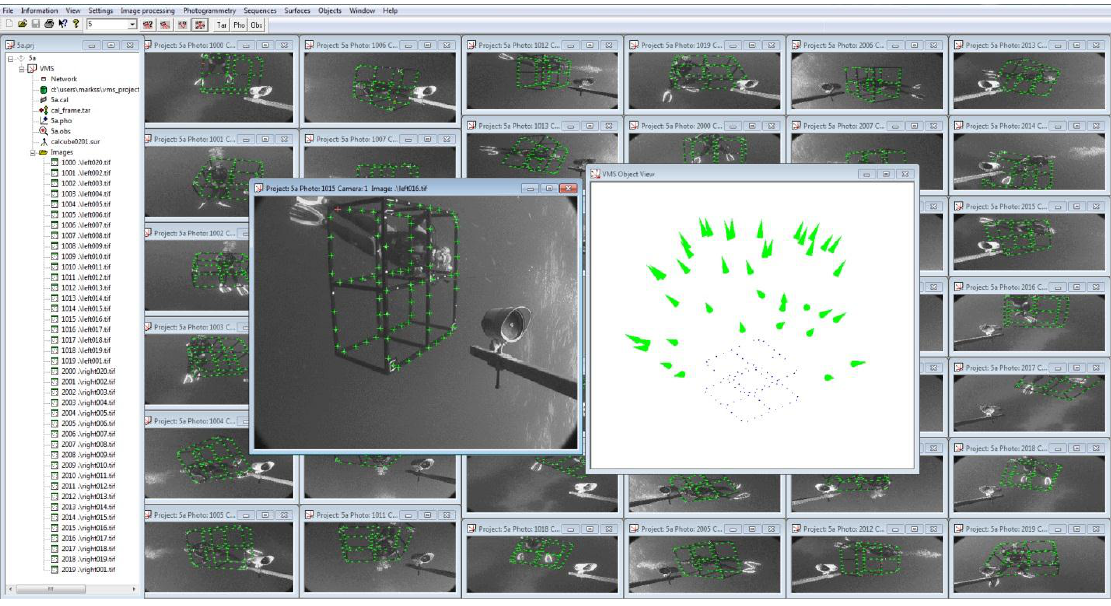
Figure 3. A full set of calibration images from an underwater stereo-video system, processed using Vision Measurement System (www.geomsoft.com/VMS). Both the cameras and the object have been rotated to acquire the convergent geometry of the network.